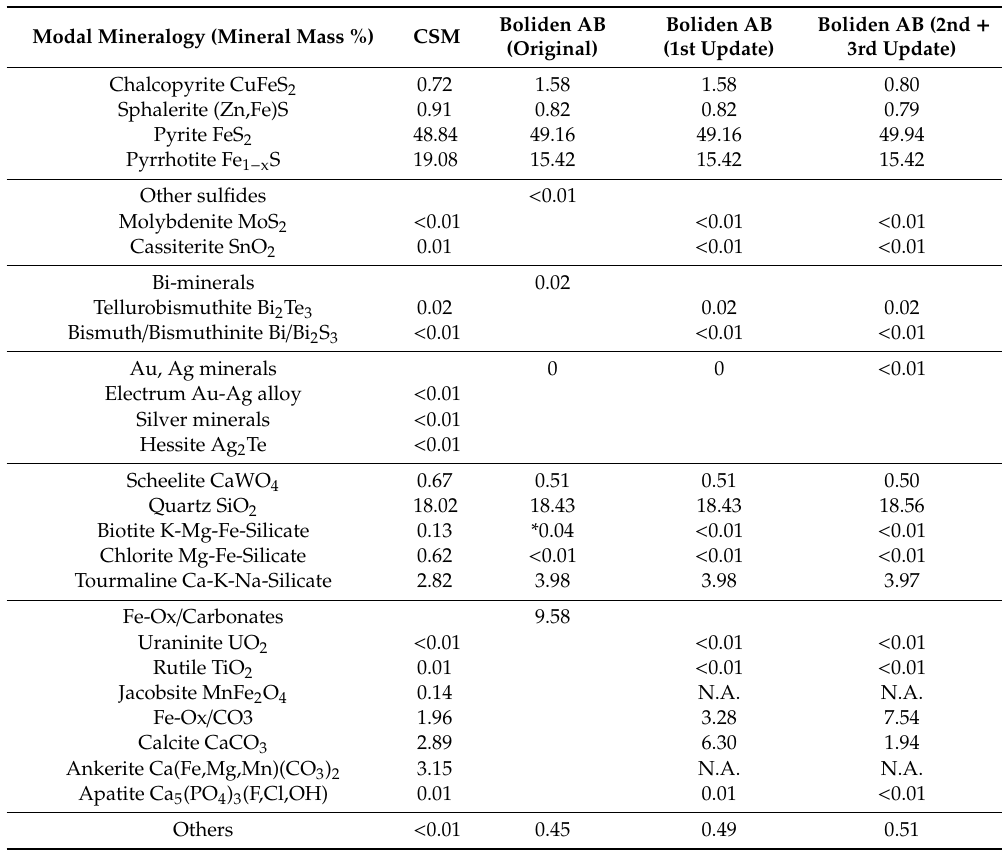
< 0.01 * the category “Silicates” was used instead of